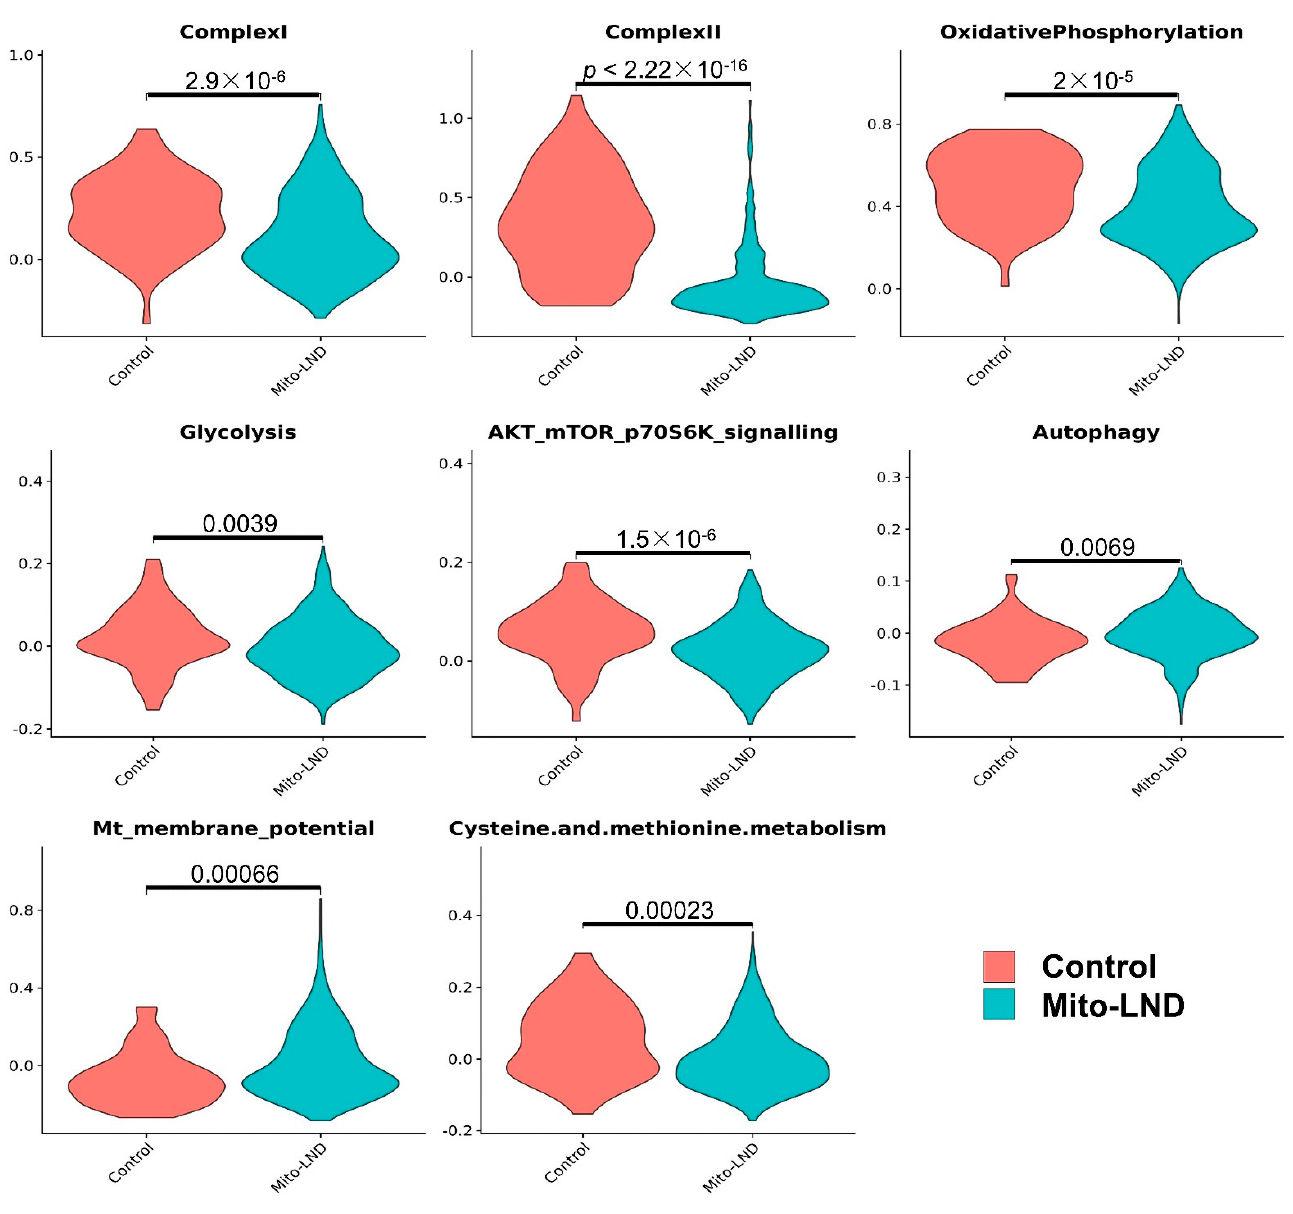
Figure 7. Pathway changes associated with Mito-LND treatment in lung adenoma cells. In the lung adenoma cells, Mito-LND treatment significantly decreased the expression of genes associated with complex I, complex II, OXPHOS and AKT/ mTOR/p70S6K signaling, and increased the expression of genes associated with autophagy. In addition, Mito-LND treatment significantly decreased cysteine and methionine metabolism, while treatment hyperpolarized the mitochondrial membrane potential in lung adenoma cells.